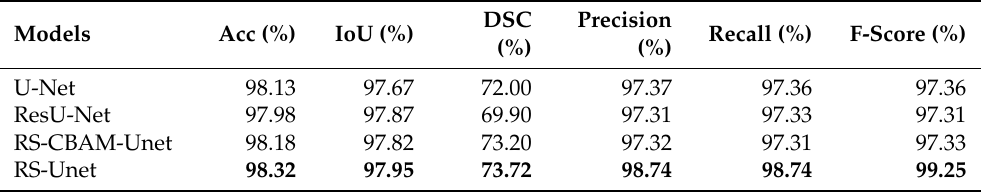
Table 3. The performance comparison with other